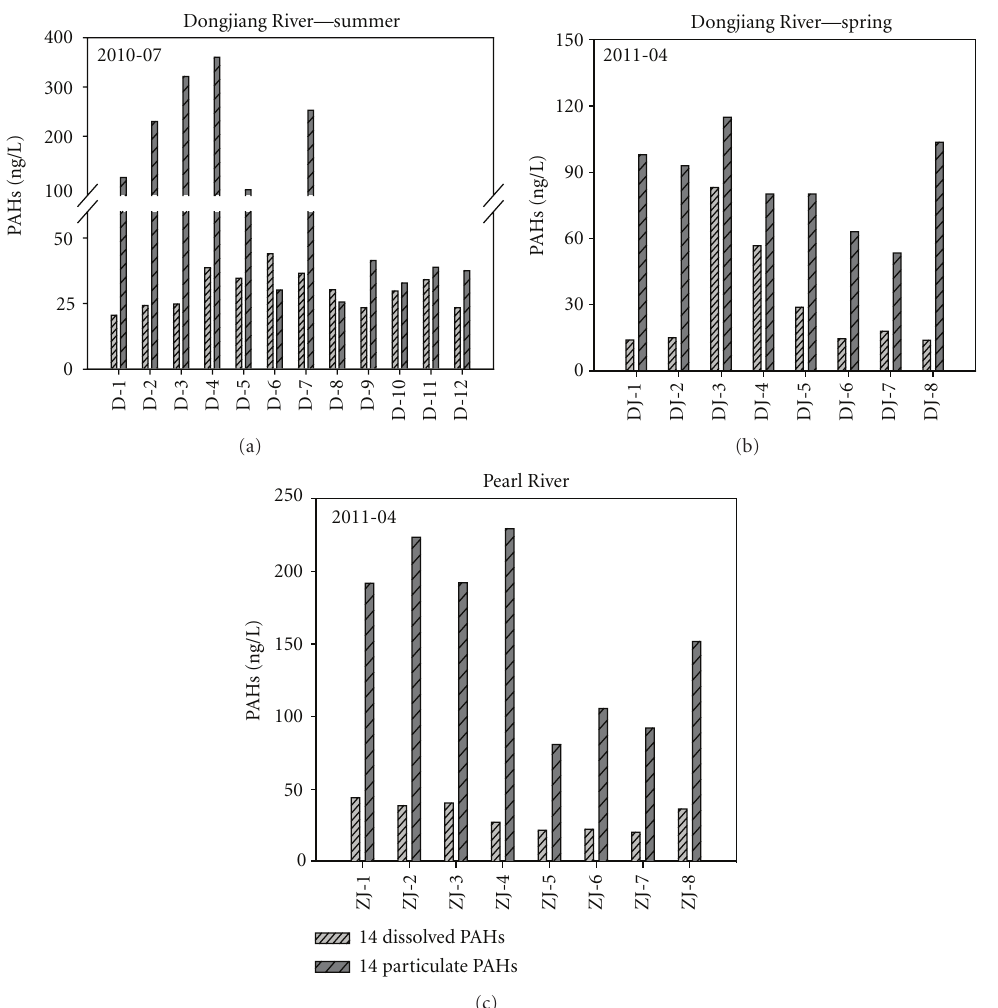
Figure 4: Spatial distribution of total PAHs in the riverine surface water and the SPM samples from the Pearl River Delta (except for Nap and